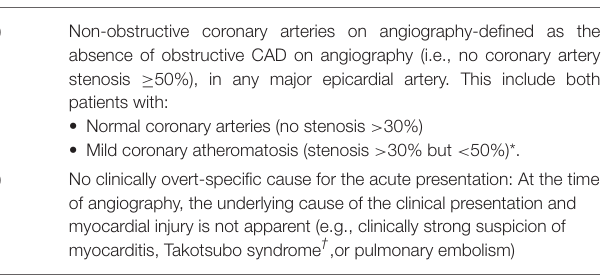
TABLE 1 | Parameters and validity of health-related quality of life